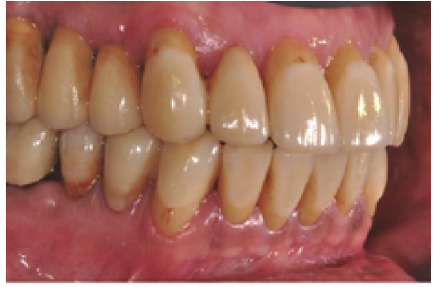
Figure 21: Lateral right view.